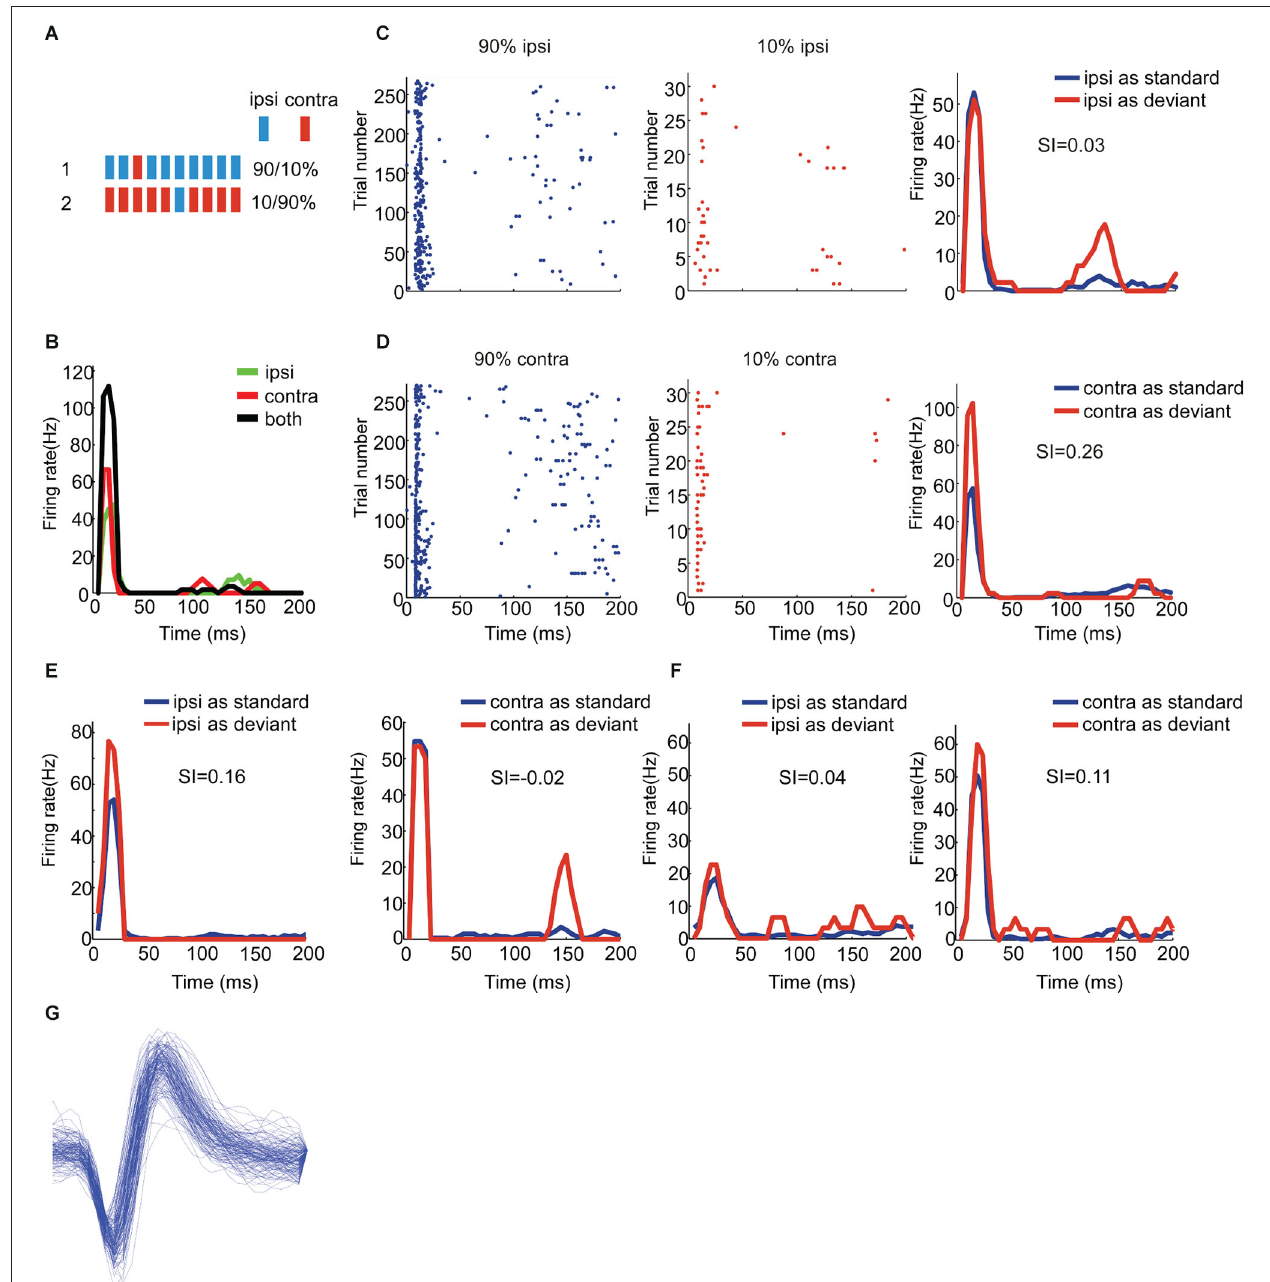
probability, the left panel) and 30 times of deviant (10% appearing probability, the middle panel) stimuli presented to the ipsilateral and contralateral ear respectively; the right panels are the PSTH shown in the left and the middle. The stimulus duration and ISI was 0.1 and 1 s respectively. (E, F) Another two examples of EE/O and EE/I neuron respectively. (G) The spike waveform of a well separated neuron showing in panel (E)